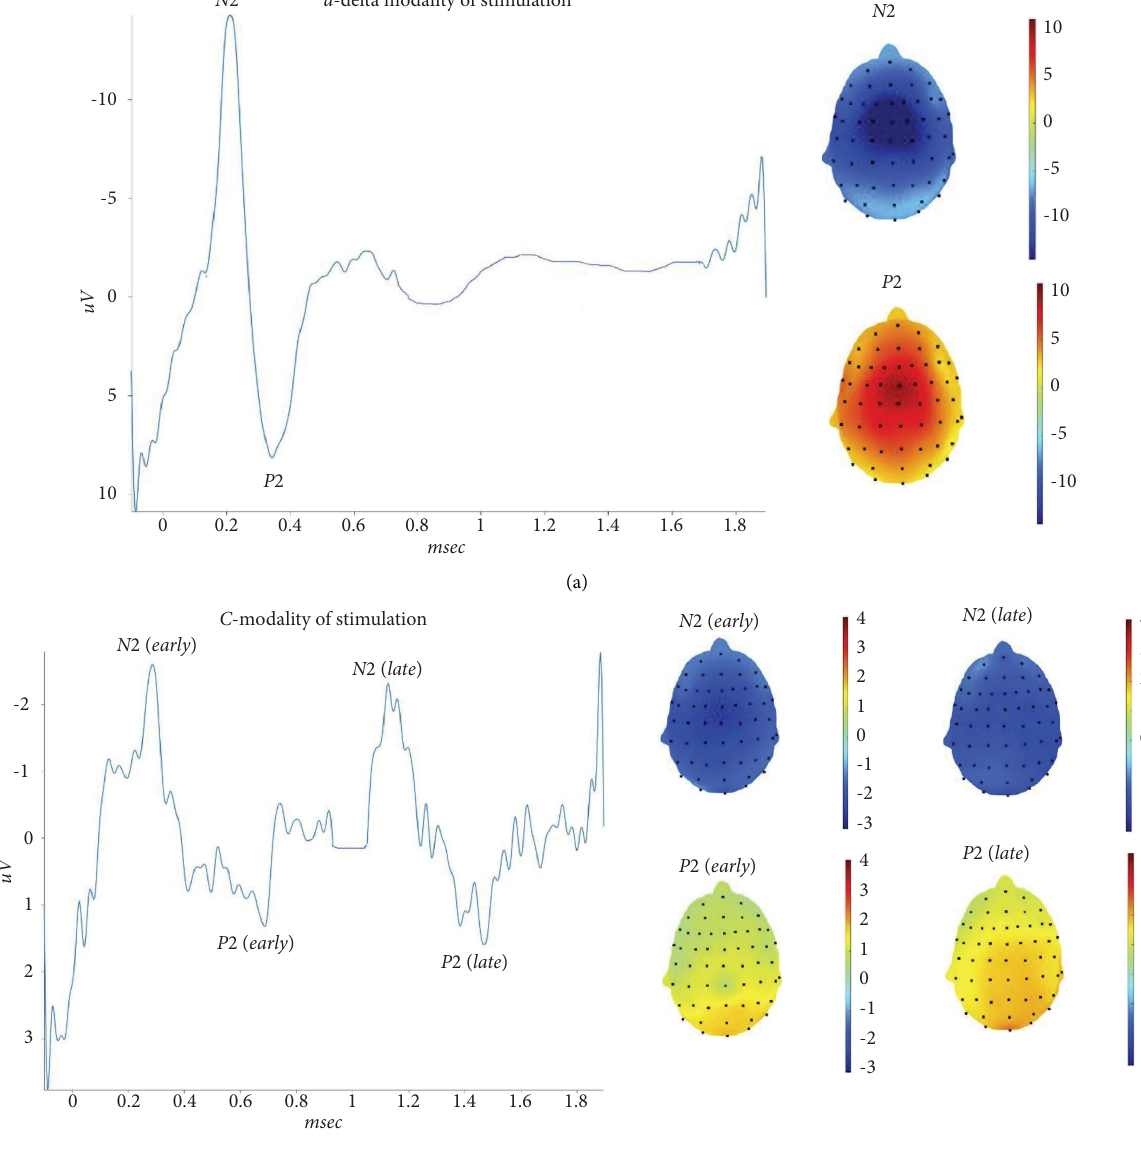
Figure 3: On the left side, the grand average of N2 P2 waves was obtained by right hand stimulation. On the right side, the corresponding topographical maps are represented. Te grand average in the lower part of the fgure, for the C-modality of stimulation, shows to distinct negative/positive (early and late) complexes. Te topographical maps refers to the recorded N2-P2 waves. Upper: a-delta modality of stimulation. Lower: C-modality of